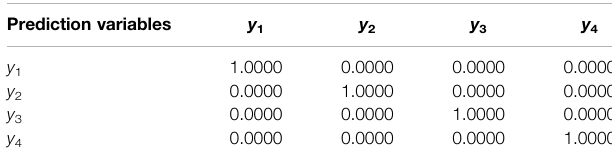
TABLE 5 | Correlation coef fi cients among the new prediction